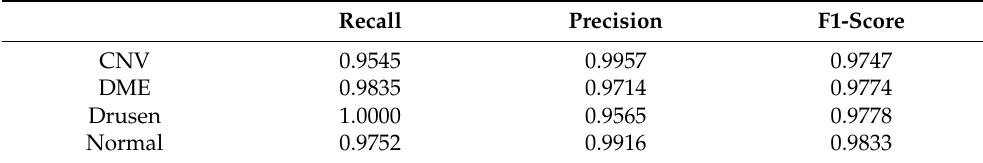
Table 8. CNN model with 11 hidden layers.